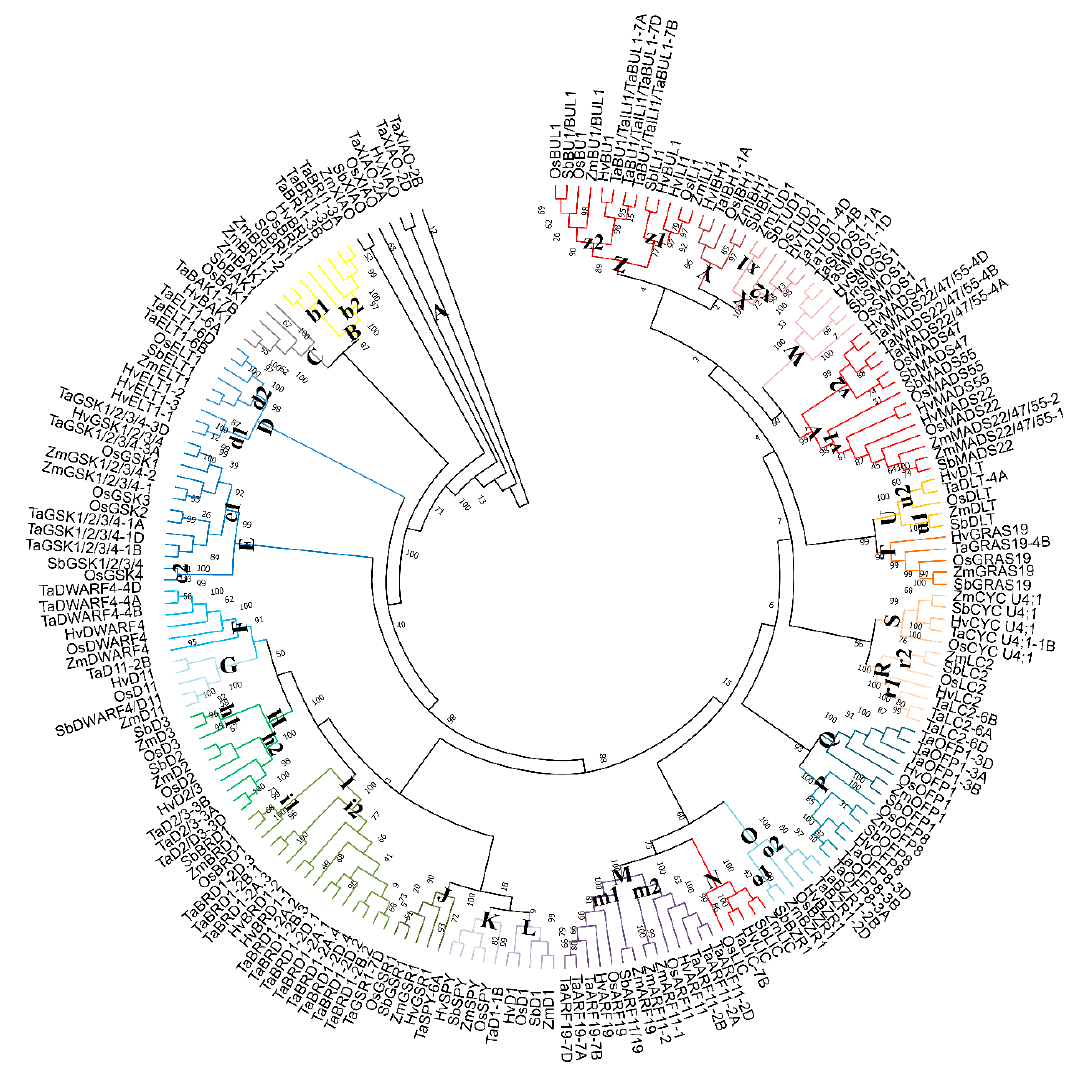
Figure 2. Phylogenetic tree of BR-related genes. Each Brassicaceae specie BR-related genes were represented by the bold letters.